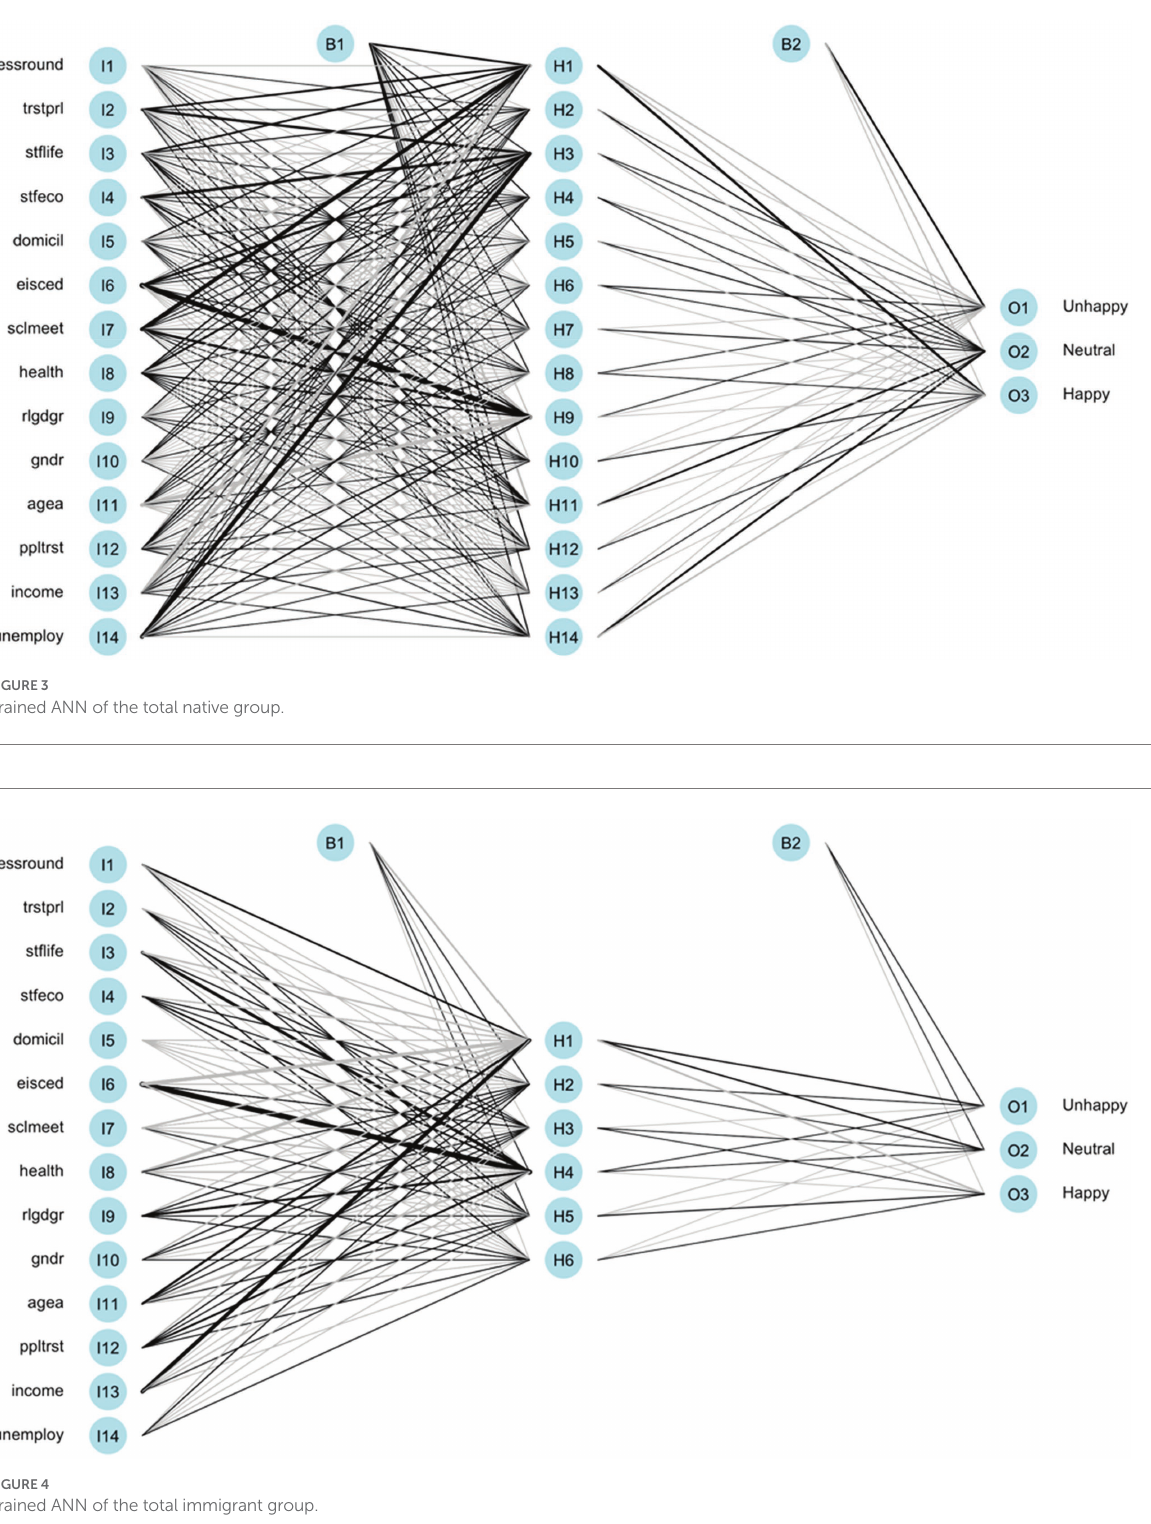
FIGURE 4 Trained ANN of the total immigrant